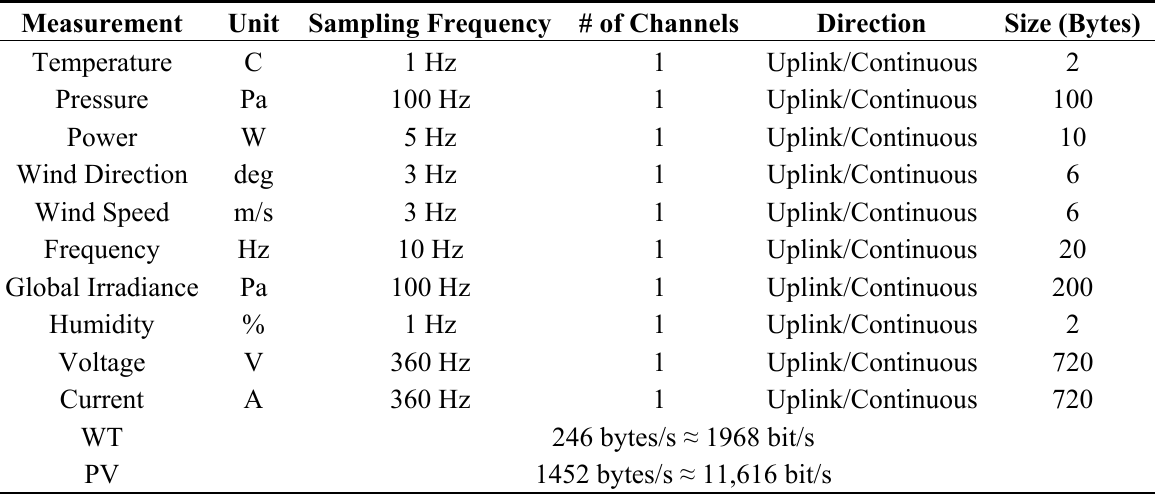
Table 5. Measuring requirements for sensor